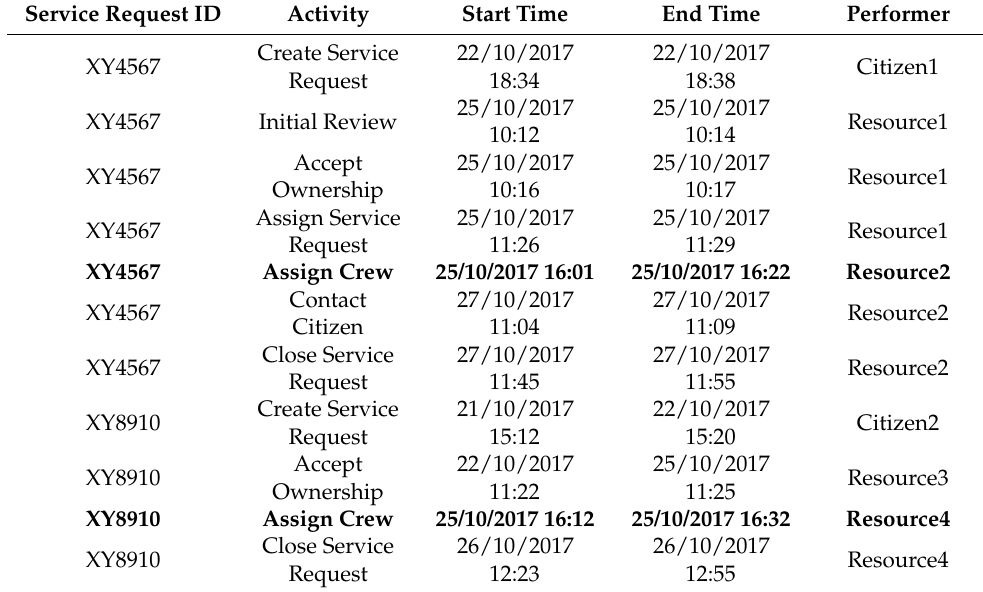
Table 1. Event Log